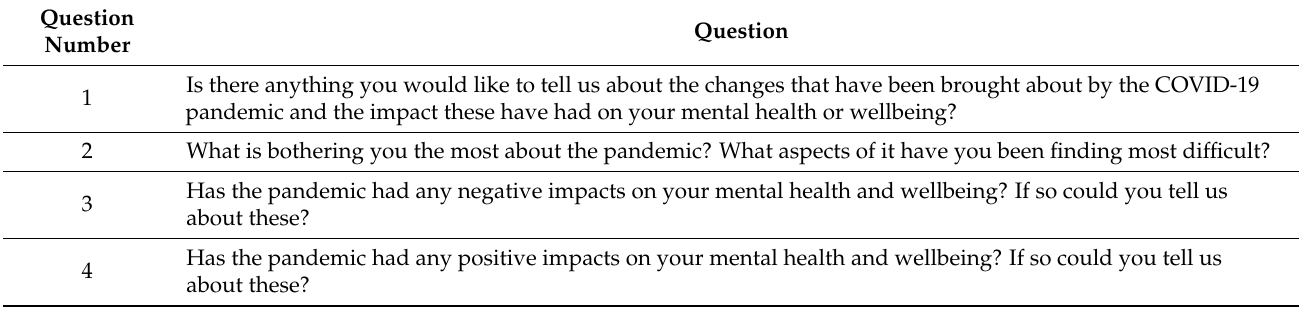
Table 1. COVID-19 Social Study Free text module